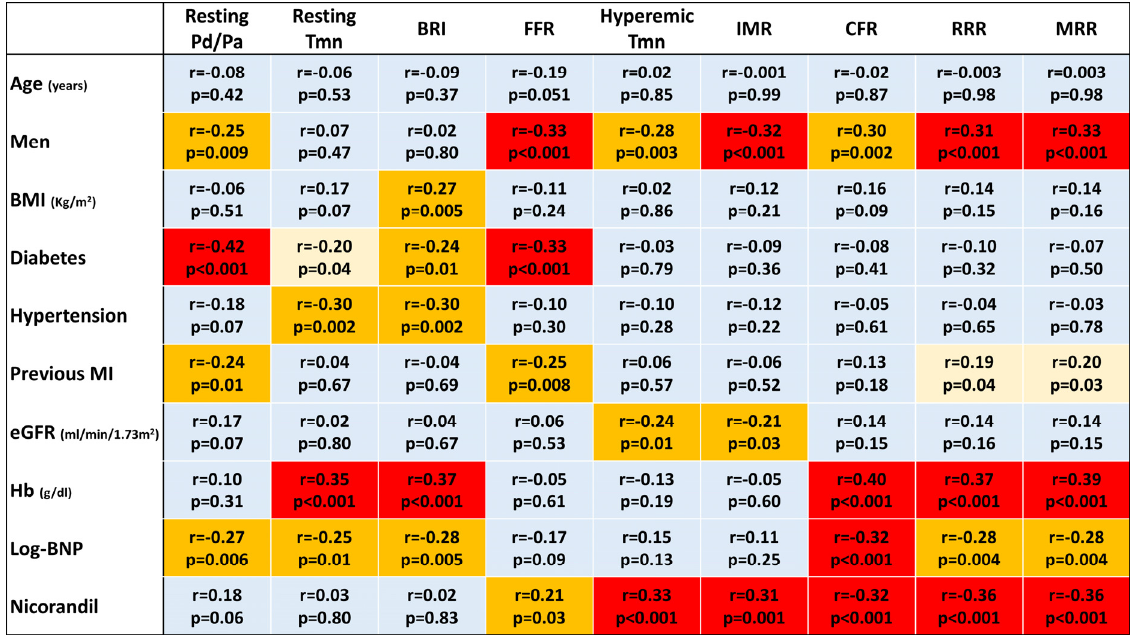
Figure 3. A heat map for univariable linear regression analyses. A cell in light blue indicates no significant association ( p ≥ 0.05). When significant associations are found ( p < 0.05), cells are displayed in light ( − 0.20 ≤ r ≤ 0.20) or warm yellow (-0.30 ≤ r <-0.20 or 0.20 < r ≤ 0.30) or red ( r < − 0.30 or r > 0.30). BMI, body mass index; BNP, brain natriuretic peptide; BRI, baseline resistance index; CFR, coronary flow reserve; eGFR, estimated glomerular filtration rate; FFR, fractional flow reserve; IMR, index of microcirculatory resistance; MI, myocardial infarction; MRR, microvascular resistance reserve; Pd/Pa, ratio of distal coronary pressure to aortic pressure; RRR, resistive reserve ratio; Tmn, mean transit time.